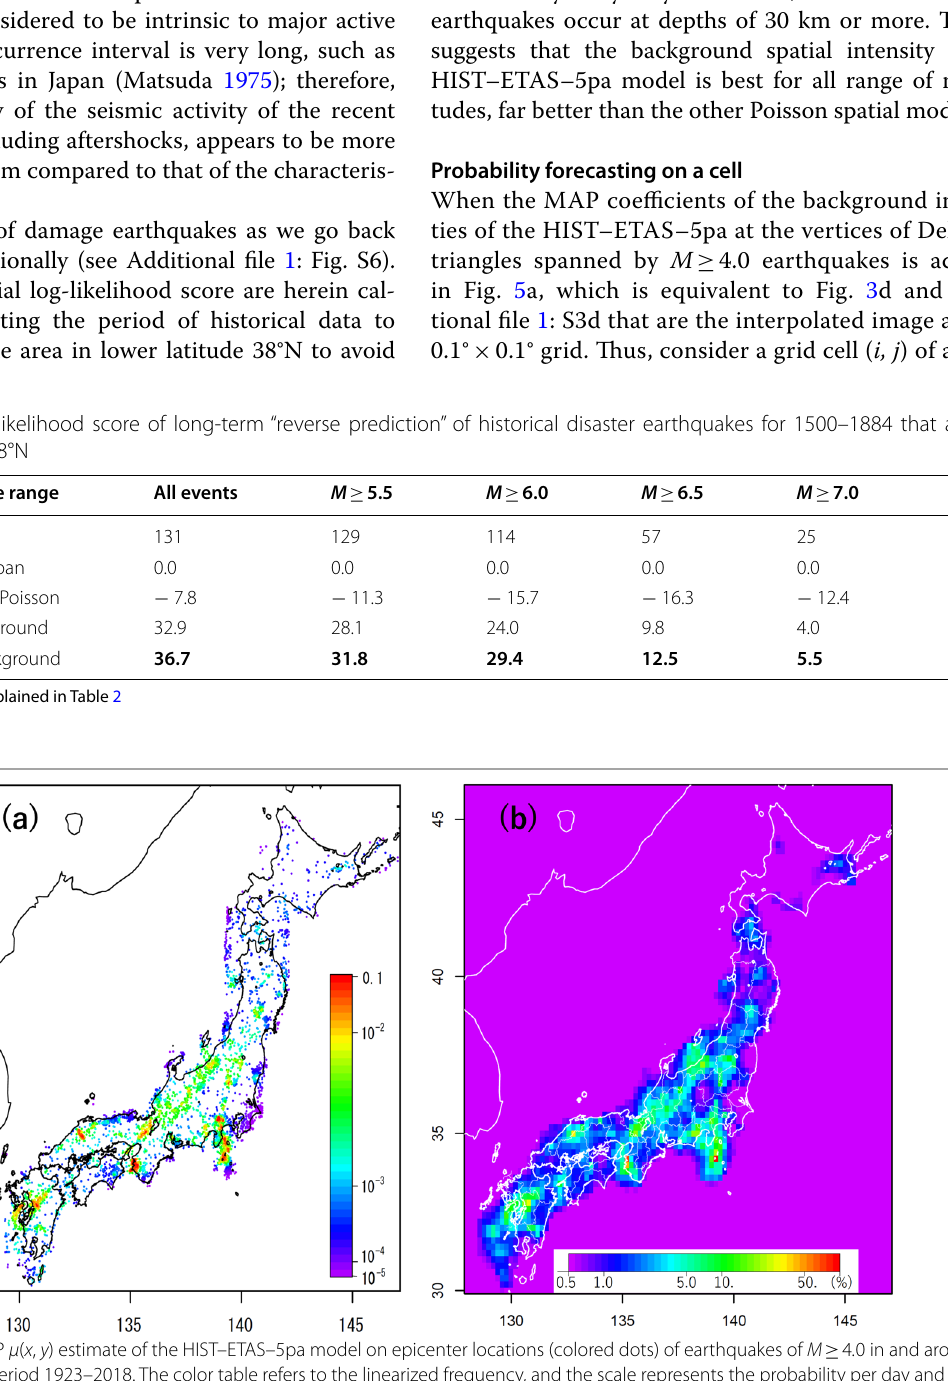
0.2° (about 400 km 2 ) cell in inland Japan assuming b ×